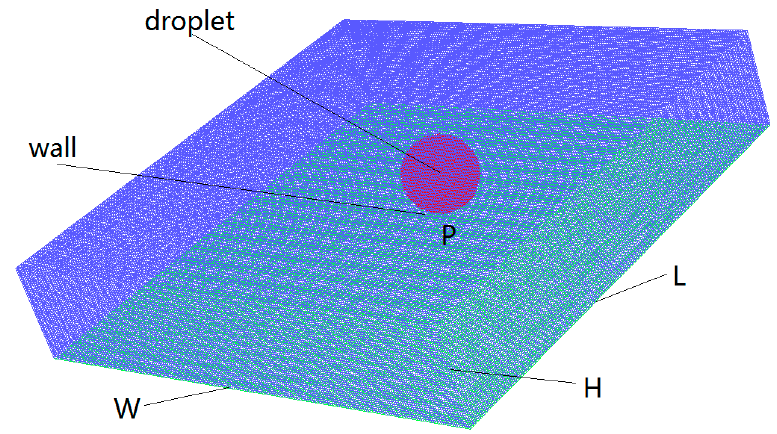
Figure 2. Grid model of moving oil droplet impacting with the wall.